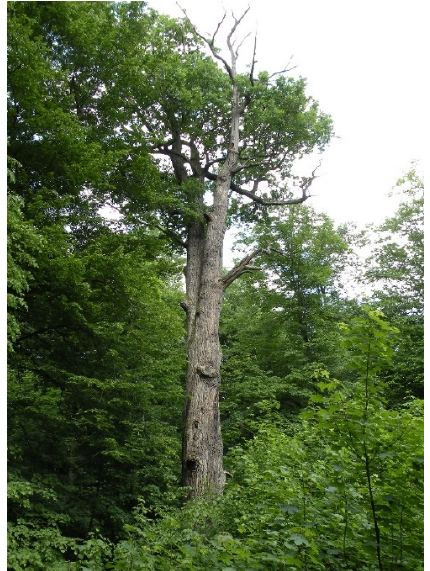
Figure 2. Forest-interior growing heritage oak